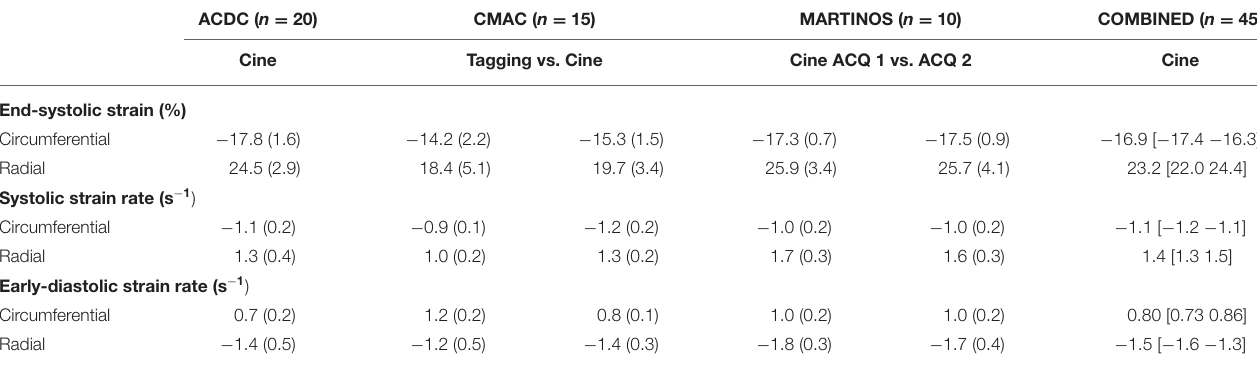
TABLE 2 | Normal ranges of strain with DeepStrain in healthy